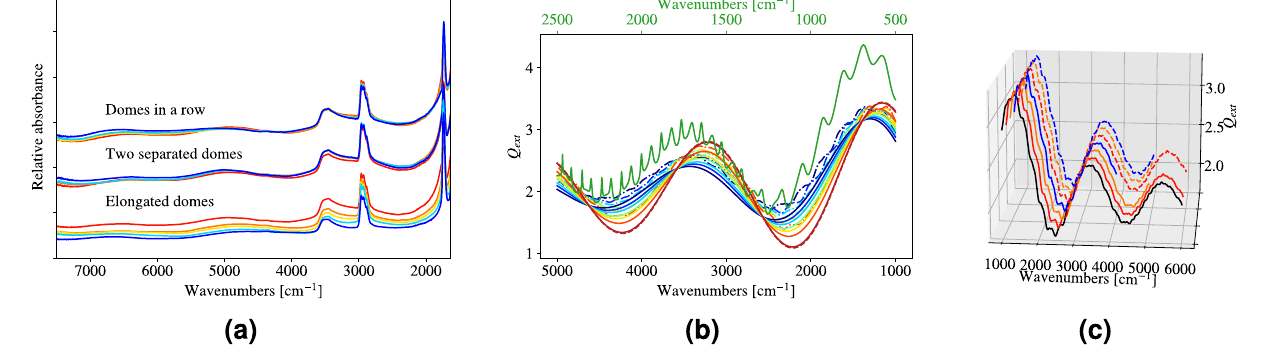
Figure 3. ( a ) Infrared absorbance spectra from dome and elongated dome samples. The mean of 4-5 replicas is shown for each configuration. In all situations the material of the domes is OrmoComp 24 and the radius of the domes is 10 µ m. The upper set shows absorbance spectra for domes in a row, from a single dome (red line) to five domes in a row (blue line). The middle set shows domes with increasing distance d = [ 0, 5, 10, 20 ] µ m (from red to blue line respectively). The lower set shows absorbance spectra for elongated domes, where the elongation L = [0, 2.5, 5, 10, 15] µ m ( b ) Extinction efficiency for an elongated dome with refractive index 1.5 for increasing elongation L . The radius of the end-caps is R = 10 µ m . The dash-dotted lines show Q ext found by electromagnetic SIE-simulations for cases where L is increased from 0 to 3 R . The solid lines show the approximations according to Eq. (A.16) where L is increased from 0 to 50 R . The red dashed line is the approximation of Q ext for an infinitely long half cylinder (Eq. A.15). The green line shows Q ext for a sphere of radius 10 µ m and refractive index of 1.5, computed via exact Mie theory. The green line is associated with the upper (green) wavenumber axis. ( c ) Simulated Q ext for a system consisting of domes in a row (solid lines) and domes with increasing distance (dashed lines). The black line is Q ext for a single dome. The number of domes ranges from one (red line) to four (blue). The wave number region is reduced for the longest array to reduce simulation time. For the domes with increasing distance, the distance d between the two domes is increased from 0 to R . For both investigations R is set to 10 µ m and the refractive index is 1.5. The lines are separated horizontally since they have a high degree of overlap. Only small differences in the ripple structure are observed between the